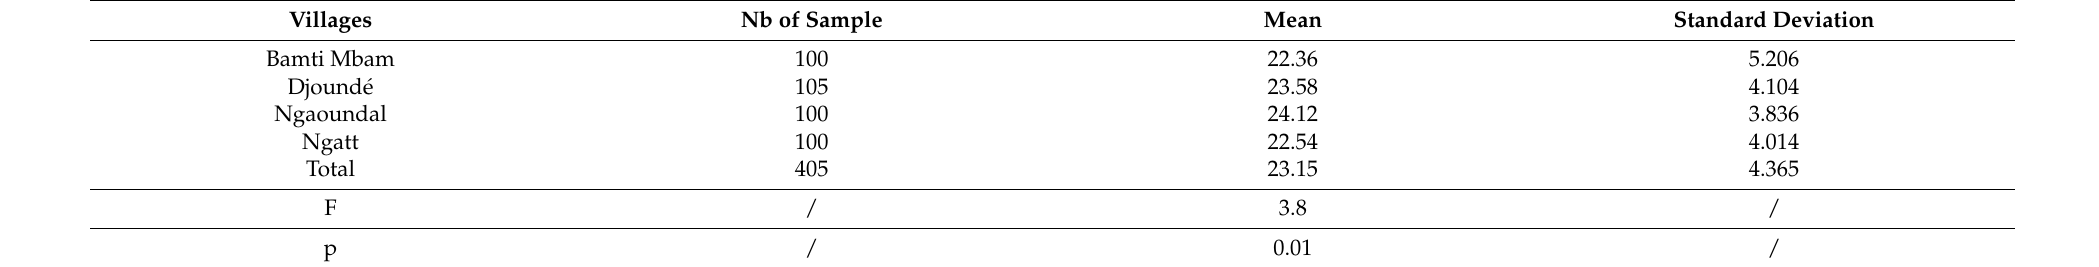
Table 3. Cattle anemia level according to sampling